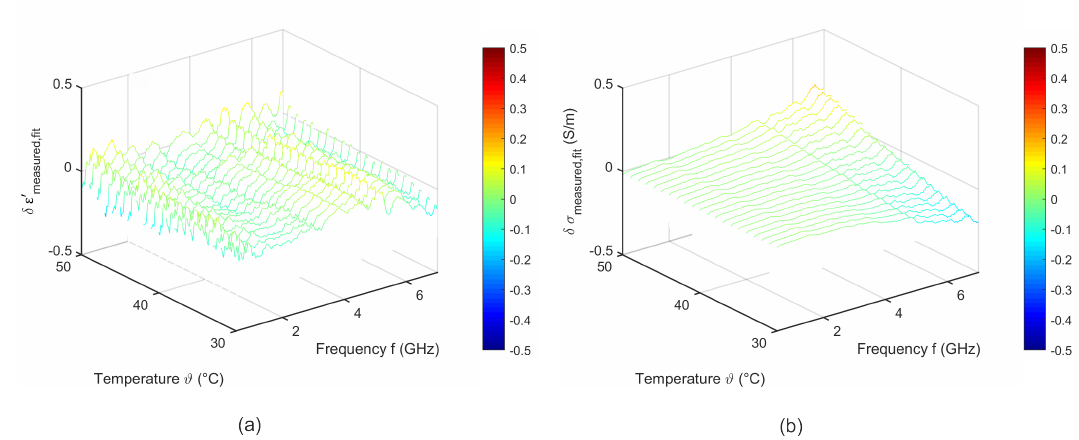
Figure 18. Difference between the measured data and the temperature dependent two pole Cole-Cole model of ( a ) relative permittivity and ( b ) effective conductivity of porcine